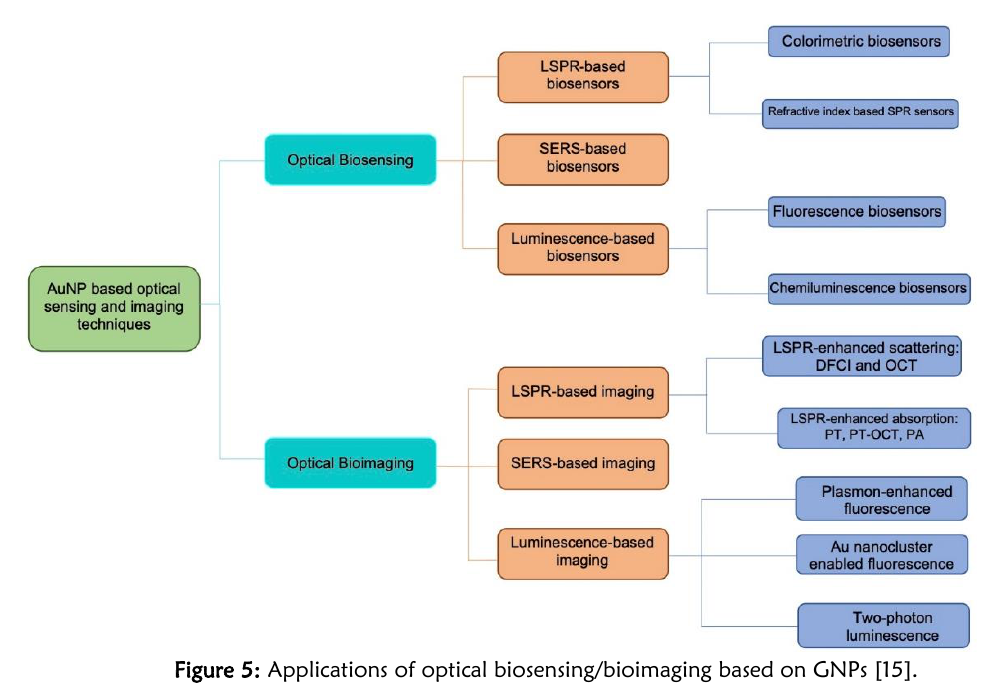
Figure 5: Applications of optical biosensing/bioimaging based on GNPs [15].